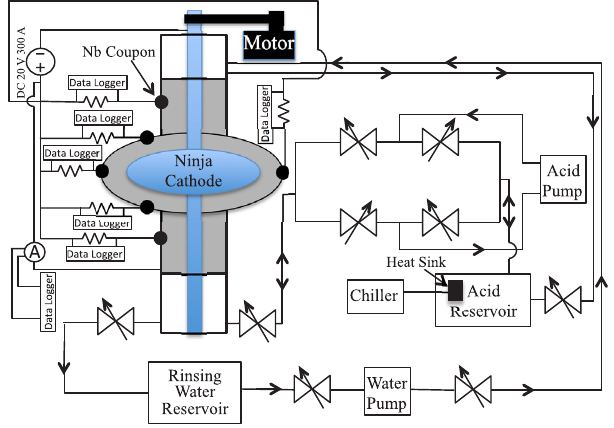
FIG. 3. Schematic of VEP setup for a one-cell cavity.